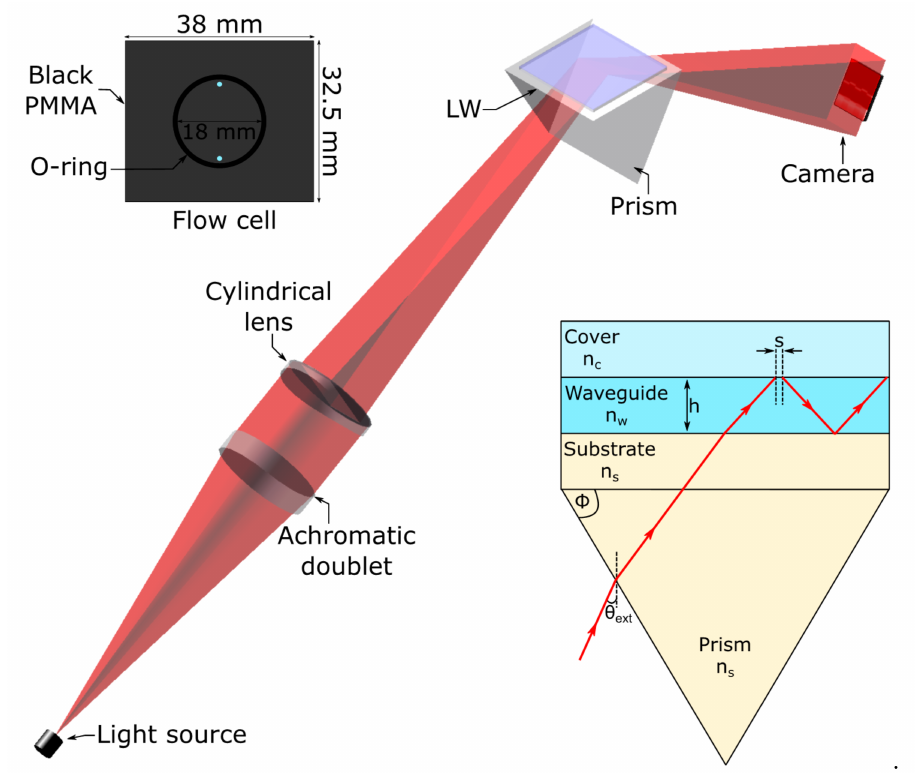
Figure 1. Schematic of the LW instrumentation (the base of the prism is 30 mm by 30 mm) where the insets show the flow cell used in this work, and a ray diagram showing partial confinement of light in LWs (where θ ext is the external angle of incidence, s is the Goos–Hänchen shift, and n c , n w , n s are the refractive indices of cover / sample, waveguide and substrate respectively. For LWs, n c < n w < n s